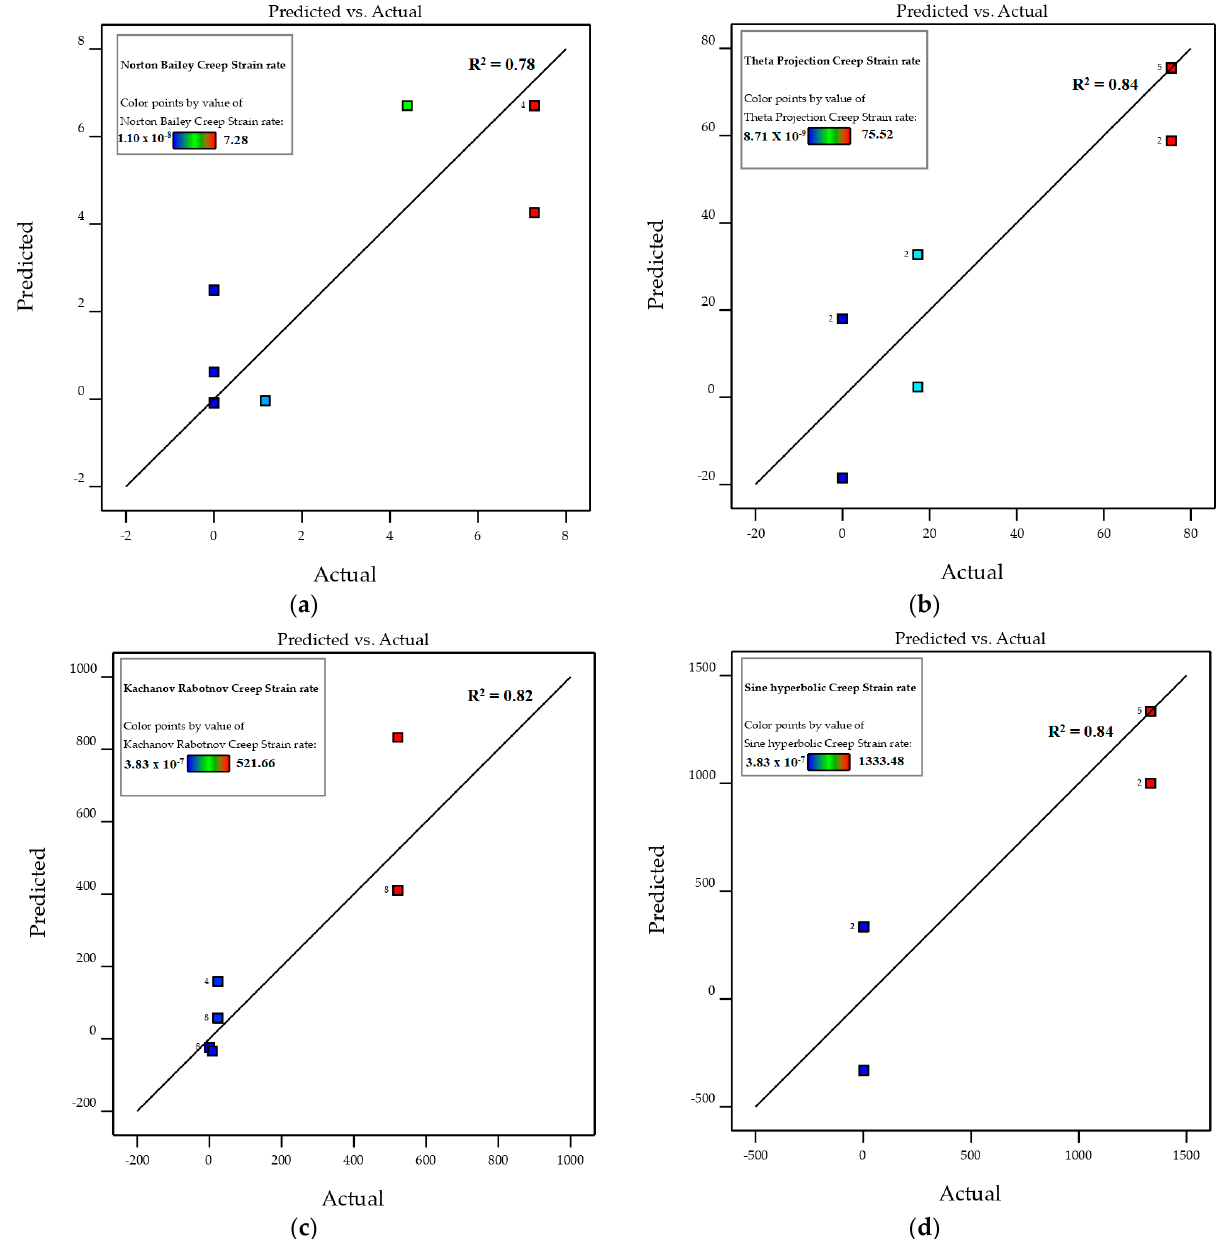
Figure 15. ( a ) The combined impact of design factors on the response NB model’s creep strain rate ( 𝜀 t ); ( b ) contour creep deformation map for NB model; ( c ) the combined impact of design factors on the response TP model’s creep strain rate ( 𝜀 t ); ( d ) contour creep deformation map for TP model; ( e ) the combined effect of design factors on the response KR model’s creep strain rate ( 𝜀 t ); ( f ) con- tour creep deformation map for KR model; ( g ) the combined effect of design factors on the re- sponse SH creep strain rate ( 𝜀 t ); ( h ) contour creep deformation map for SH model.